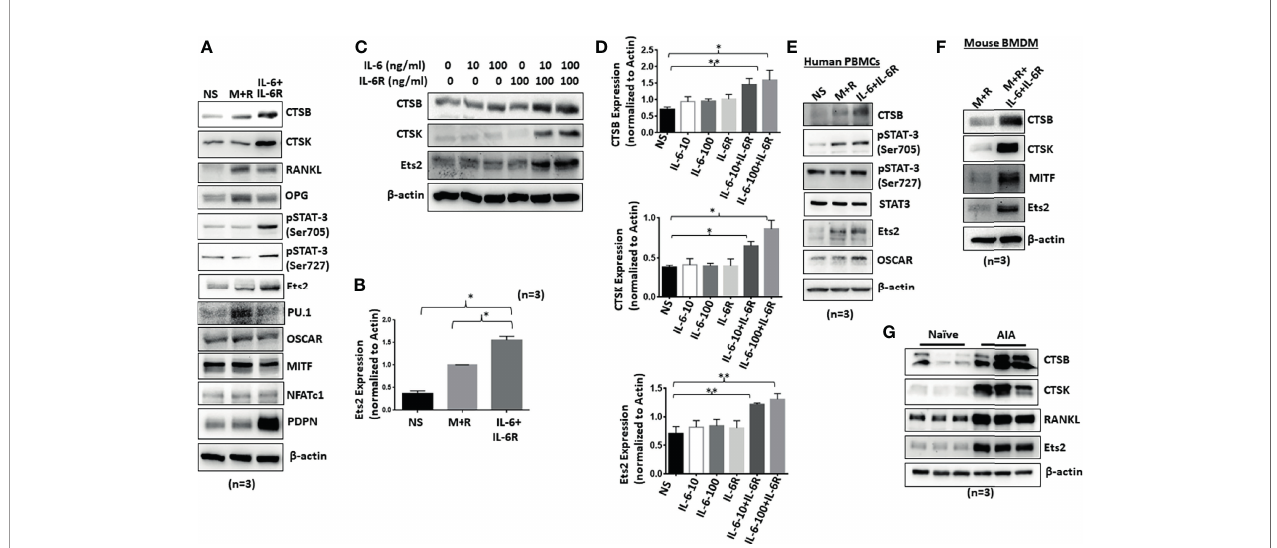
FIGURE 2 | Chronic exposure of IL-6/IL-6R induces cathepsin K, cathepsin B, and Ets2 expression in RASFs. (A) Western blot analysis of whole cell extracts prepared from human RASFs grown in the presence of IL-6+IL-6R for 12 days shows upregulation of endogenous CTSB, CTSK, RANKL, and Ets2. (B) Quantitative analysis of Ets2 expression reveals signi fi cant upregulation of Ets2 expression in response to IL-6+IL-6R treatment for 12 days. (C, D) CTSK, CTSB, and Ets2 were upregulated speci fi cally in the presence of both IL-6 and IL-6R in human RASFs. (E) Human PBMC-derived osteoclast progenitor cells were stimulated with either M-CSF+RANKL or IL-6+IL-6R for 12 days. Western blot analysis of whole cell extracts prepared from these cells showed increased expression of CTSB and Ets2 in response to IL-6 trans- signaling. (F) CTSB, CTSK, and Ets2 expression was upregulated in mouse BMDMs in response to M-CSF+RANKL or IL-6+IL-6R. (G) Joint homogenates prepared from adjuvant-induced arthritis (AIA) rats show signi fi cant upregulation of CTSB, CTSK, RANKL, and Ets2 expression.**p < 0.01 while *p <